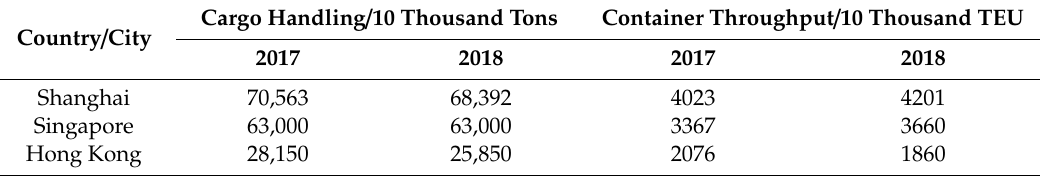
Table 2. Statistics of cargo throughput and container throughput of three